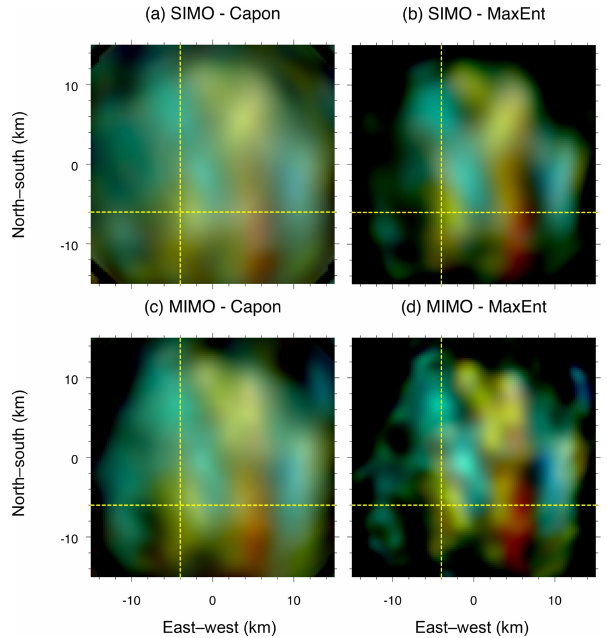
Figure 5. Same as Fig. 3 but at 05:56:13UT on 17 July 2017, i.e., Event 2. The yellow dashed horizontal and vertical lines represent the location of the NS/EW cuts shown in later figures for Event 2.